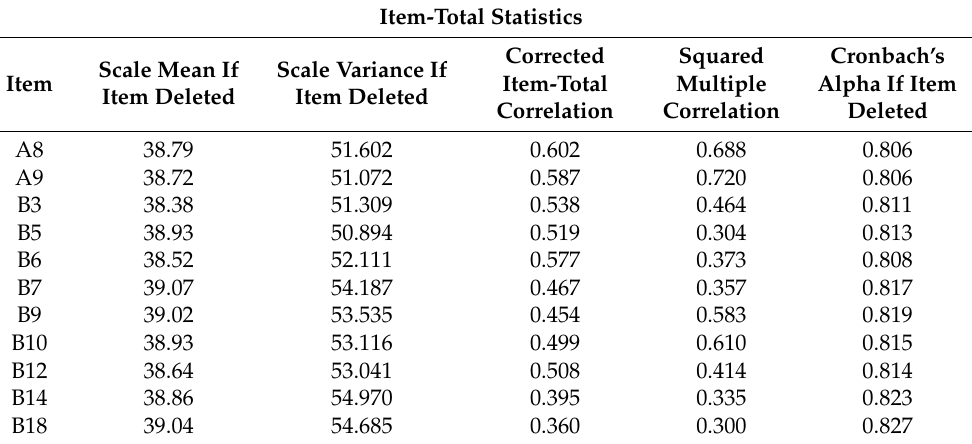
Table 7. Factor 2 corrected item total correlation and Cronbach’s alpha if item